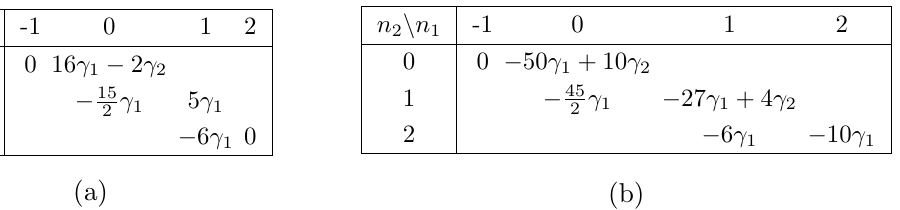
(a) The net number of families as a function of the parameters (cid:13) 1 and (cid:13) 2 ( F = (cid:13) 1 D 1 + (cid:13) 2 D 67 ) (b) The di(cid:11)erence among the chiralities for the split matter curves (cid:1) (cid:31) ( 3 ; 1 ) (cid:31) ( 3 ; 1 ) 1 = 3 (cid:0) (cid:31) ( 3 ; 1 ) 1 = 3 (1 ; (cid:0) 1) (0 ; 2)